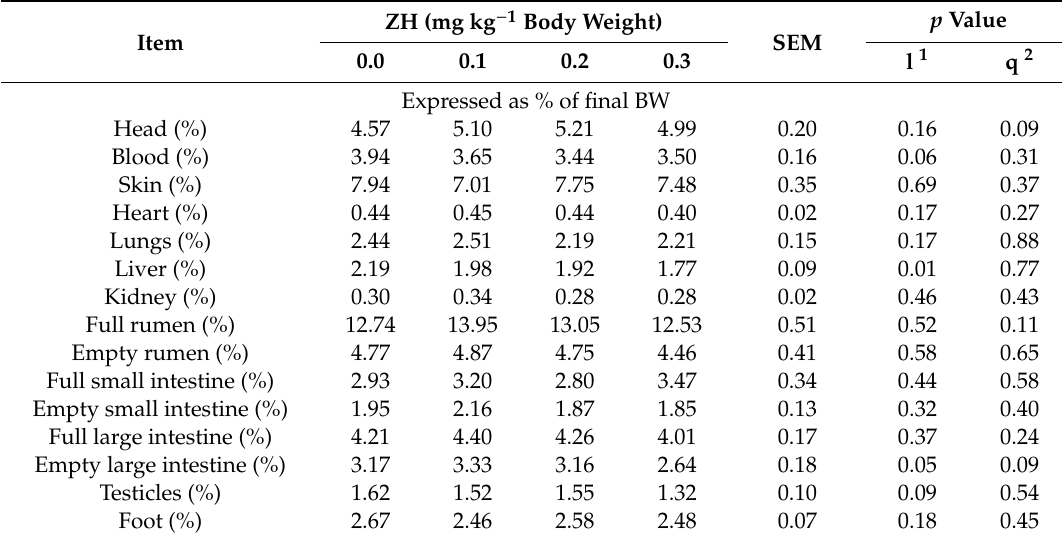
Table 5. Percentage of non-carcass components of hair-breed lambs supplemented with di ff erent levels of ZH for 29